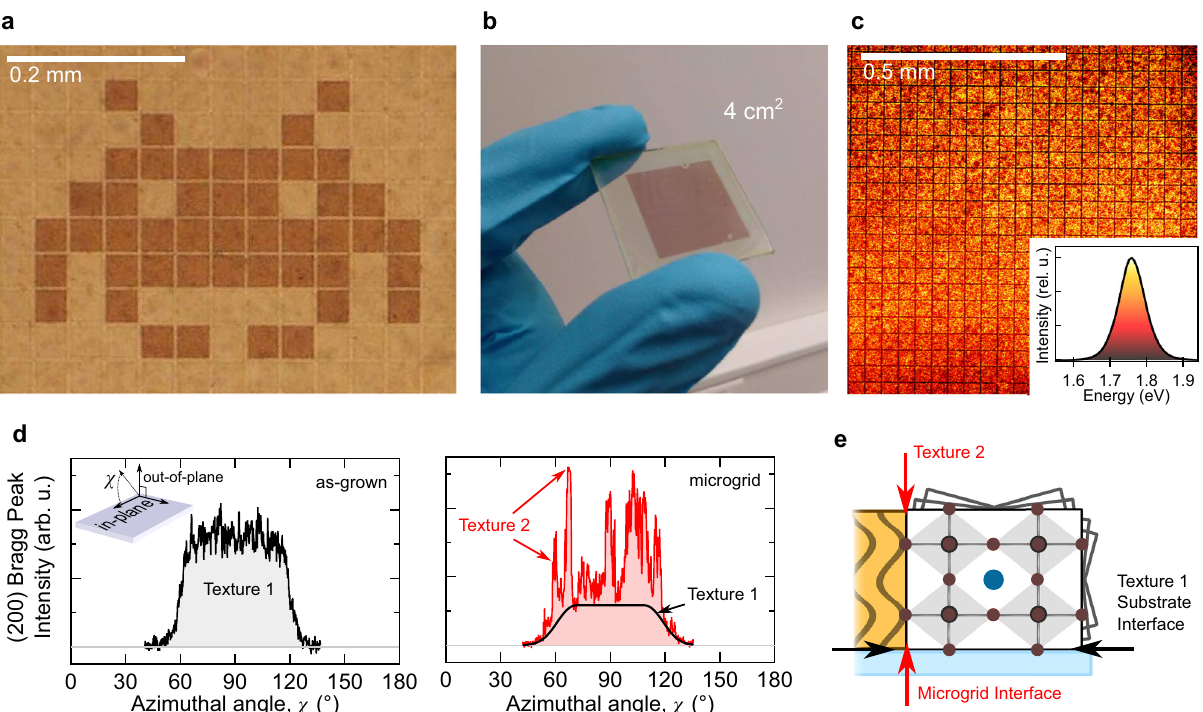
Fig.3|Scalingphotolithographyandprobingofmicrogridinterface.a Imageof graphic encoded into a microgrid thin fi lm using selective laser destabilization. b Photograph of an ambient-stable microgrid (40 µ m) thin fi lm after annealing. c Confocal fl uorescence micrograph of a processed CsPbI 3 perovskite thin fi lm (488nm excitation/695 – 705nm detection). A representative full PL spectrum is shownin the inset and acts asthe color scaleof the fl uorescenceimage. d GIWAXS